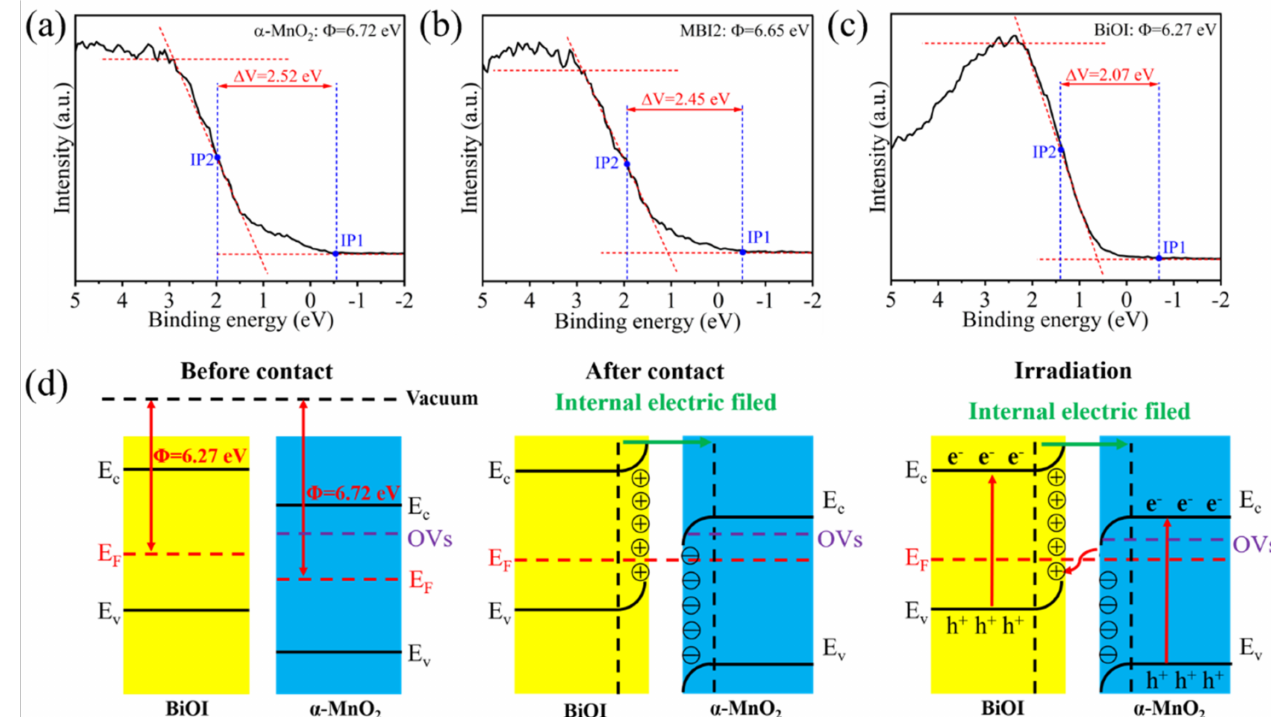
Figure 16. The work function of ( a ) α -MnO 2 , ( b ) BiOI, and ( c ) MBI2 composite measured by VB XPS; ( d ) mechanism of internal electric field and charge